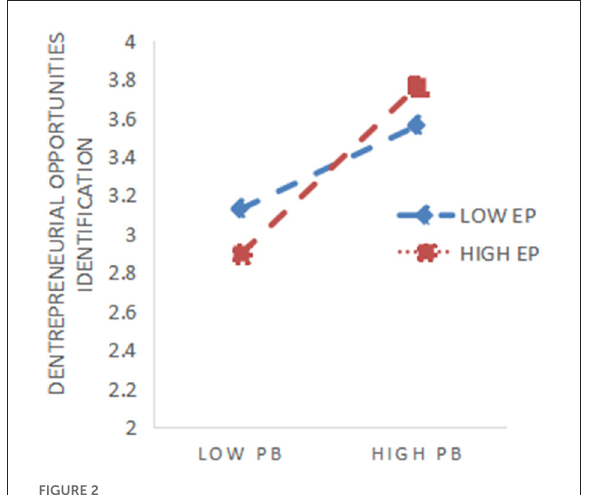
FIGURE2 Moderating effect of EP on PB.